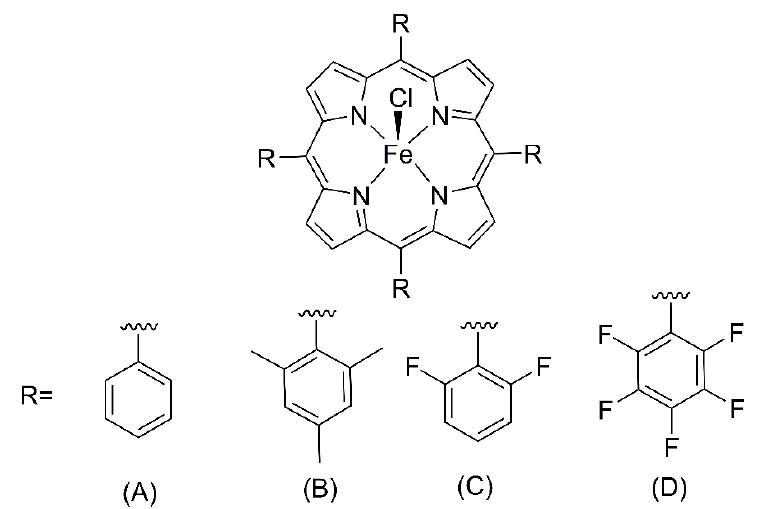
Figure 1. Iron (III) porphyrins mentioned in this work: (A) [5,10,15,20-tetrakis(phenylporphyrin) iron (III)] chloride, [Fe(TPP)]Cl ( Fe0F ); (B) [5,10,15,20-tetrakis(mesitylporphyrin) iron